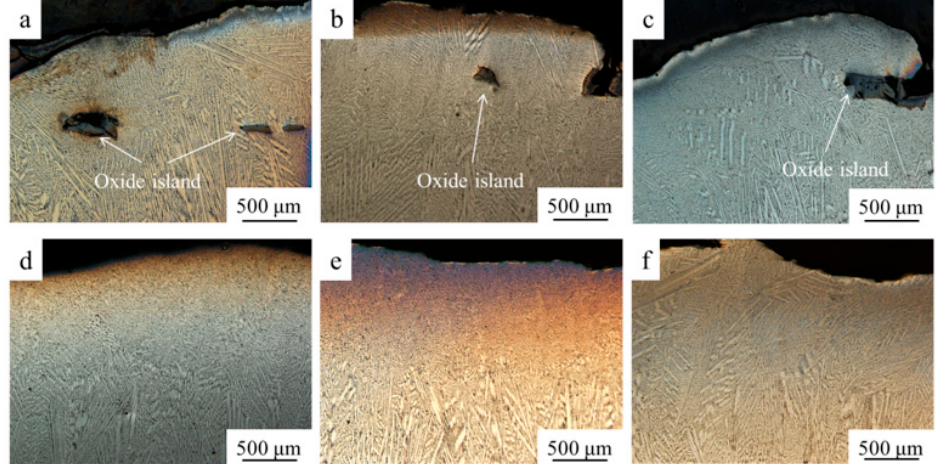
Figure 3. Microstructure of NiCrAlY-ZrO 2 composites sample in low magnification. ( a ) 10% ZrO 2 composites without ultrasonic vibration, ( b ) 20% ZrO 2 composites without ultrasonic vibration, ( c ) 30% ZrO 2 composites without ultrasonic vibration, ( d ) 10% ZrO 2 composites with ultrasonic vibration, ( e ) 20% ZrO 2 composites with ultrasonic vibration, ( f ) 30% ZrO 2 composites with ultrasonic vibration.